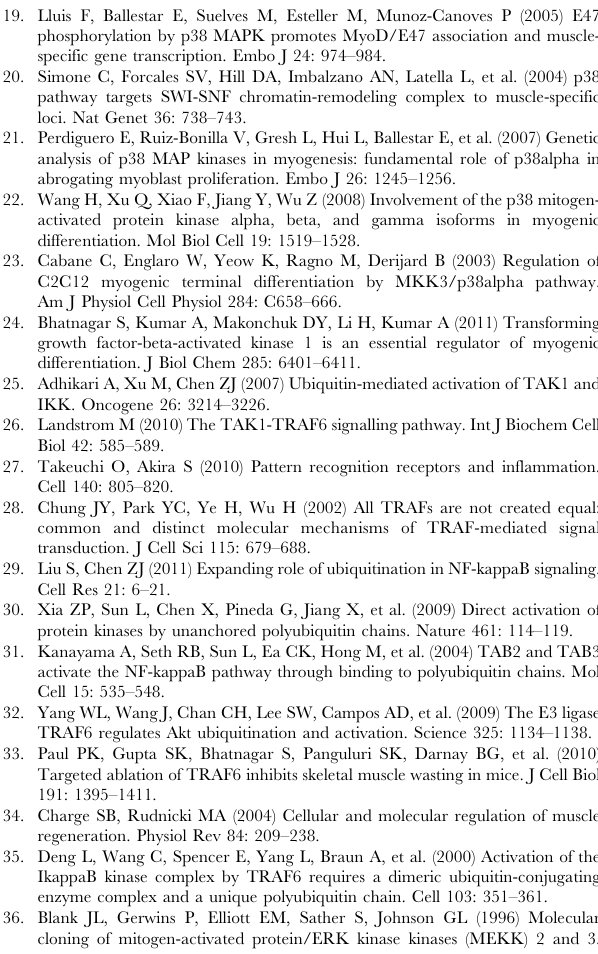
Figure S2 TRAF6 knockdown did not affect macrophage infiltration. (A–C) TA muscles of adult mice were injected with CTX followed by treatment with the GFP-siRNA and TRAF6- siRNA as described above in the legend of Fig.S1. TA muscles were collected at day 2 after CTX injection. Non-injured TA muscles were used as a control. Muscle sections or total RNA were prepared and subjected to immunostaining for CD68 (A, B) or RT-qPCR analysis for relative mRNA expression of CD68, F4/ 80, and TRAF6 (C). Images in (A) were taken with a 4 6 objective, while the same images in (B) were taken with a 20 6 objective. The nuclei were counterstained with